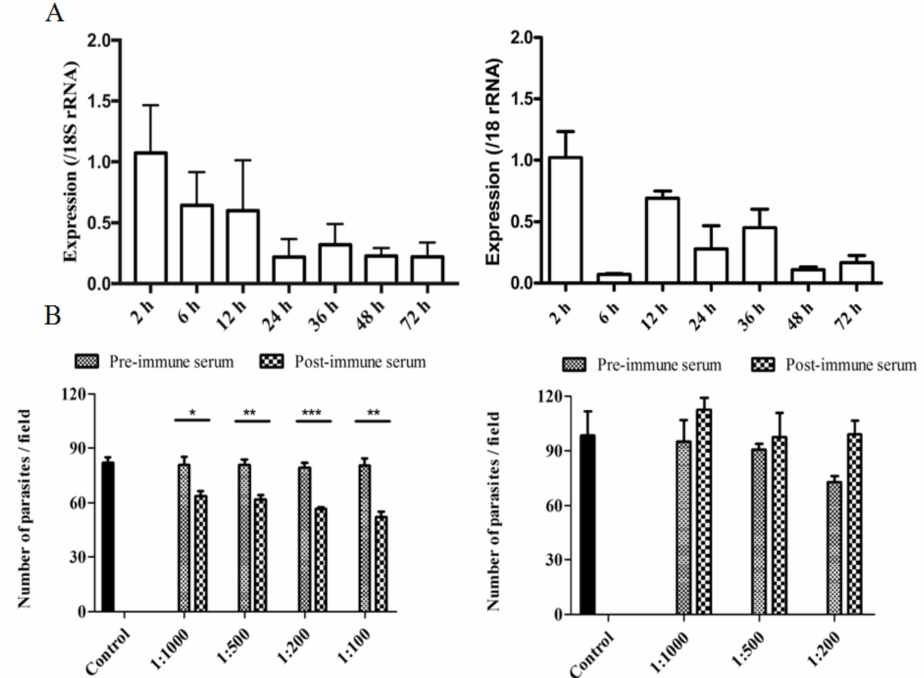
Figure 4. Assessment of biological functions of CpINS-4 and CpINS-6 in Cryptosporidium parvum. ( A ) Relative expression level of the cgd2_930 (left panel) and cgd2_4270 genes (right panel) at different time points of C. parvum -infected HCT-8 culture as determined by qPCR. The error bars presented represent standard deviations of the means from three replicate assays. ( B ) Neutralization efficiency of the polyclonal anti-CpINS-4 (left panel) and anti-CpINS-6 (right panel) antisera on C. parvum infection of HCT-8 cells. Hypochlorite-treated oocysts were preincubated with 1:1000, 1:500, 1:200, and 1:100 dilutions of postimmune sera, with preimmune serum as controls. Parasite loads in 50 random 200 × microscope fields were determined and compared with treatment groups. Each bar represents mean ± SD from three replicate assays. * P < 0.05, ** P < 0.01, *** P <